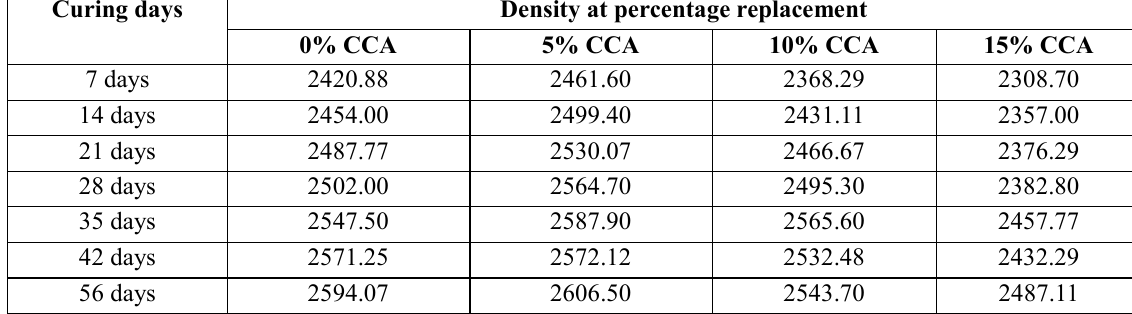
Density of CCA Replaced Specimens at Different Curing Ages (kg/m 3 ).